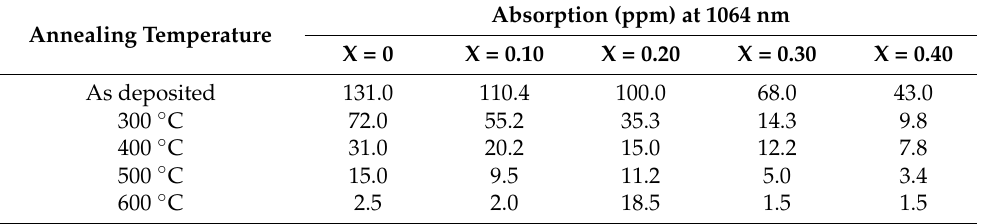
Table 2. The weak absorption at 1064 nm of the Hf 1 − x Si x O 2 nanocomposite coatings annealing at different temperature.